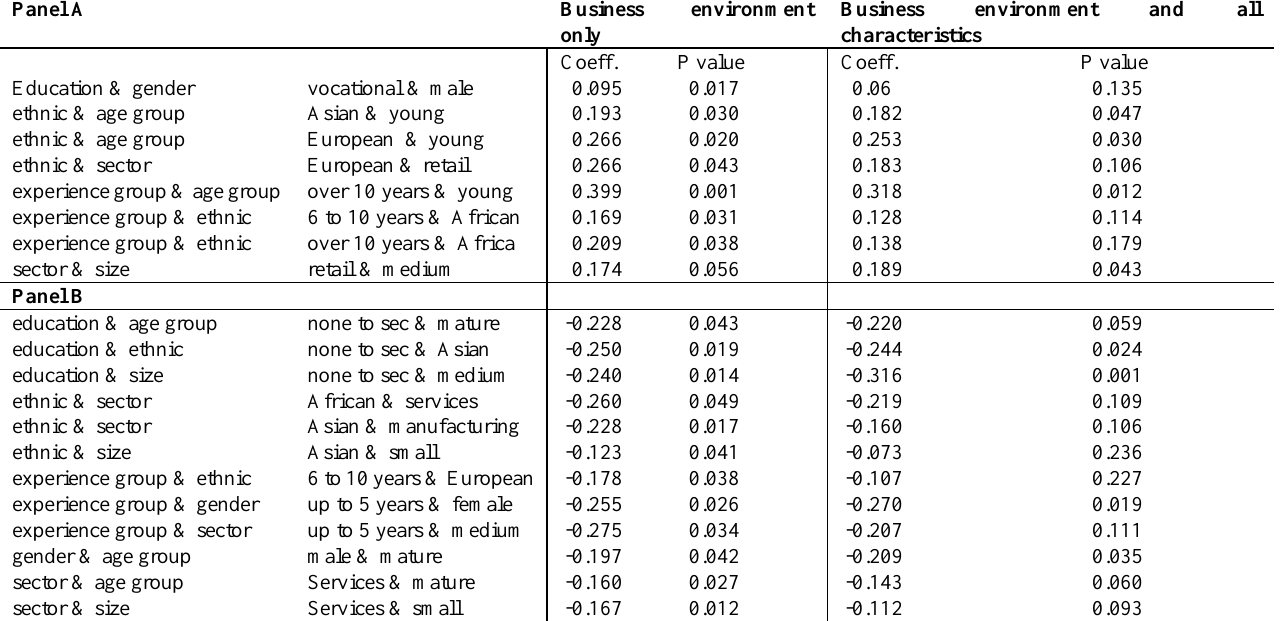
Table 3: OLS interactions significantly distinguishing outperformers and underperformers Panel A Business